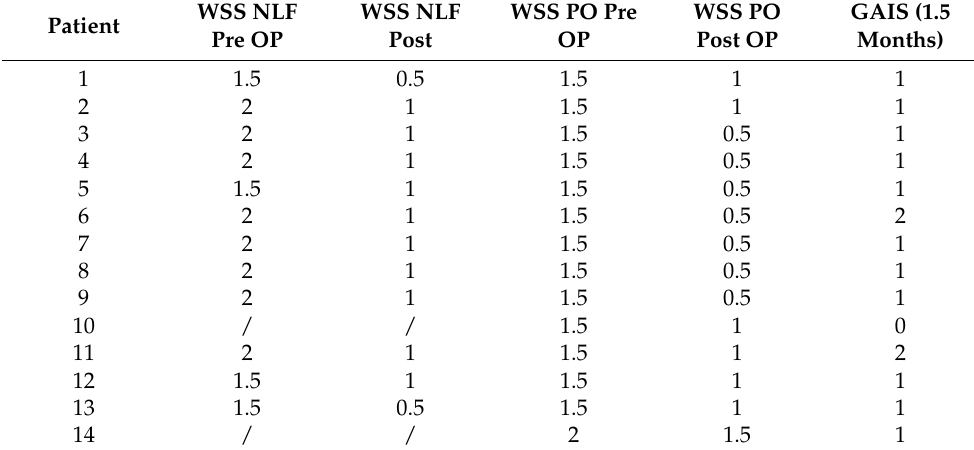
Table 2. Follow up 6 weeks: Wrinkle severity scale (WSS) for different facial regions pre- and postoperative and global aesthetic improvement scale (GAIS).